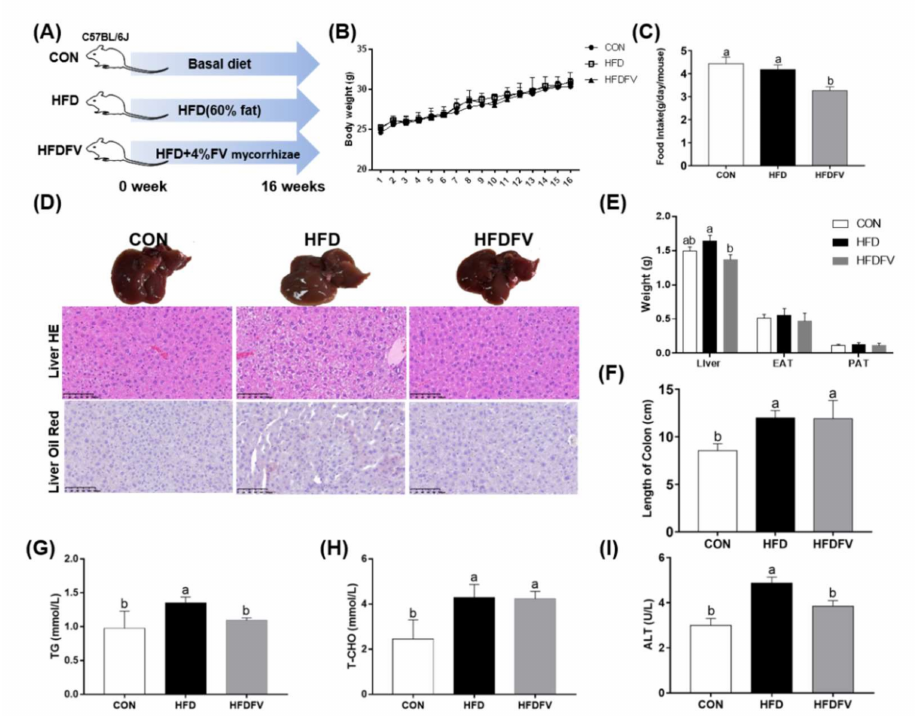
Figure 2. Effect of FV mycorrhizae on the HFD-induced body weight, food intake, liver histopathol- ogy and plasma lipids abundance in mice. ( A ) The experimental design. CON: control group, mice were received basic diet. HFD: high fat diet group, mice were received 60% high fat diet. HFDFV: high fat diet + 4% FV mycorrhizae group, mice were received 60% high fat diet supplemented with 4% FV mycorrhizae powder; ( B ) The body weight; ( C ) Food intake; ( D ) The liver morphology, HE and oil red staining; ( E ) The weight of liver, PAT and EAT; ( F ) The length of colon; ( G ) The content of plasma TG; ( H ) The content of plasma TC; ( I ) The activity of plasma ALT. C57BL/6J mice were divided into 3 groups and were fed either basal diet (CON, 10% fat), high-fat diet (HFD, 60% fat) or HFD + 4% FV (HFDFV) for 16 weeks. Values with different letters differ significantly ( p < 0.05). Values were expressed as mean ± SEM ( n =